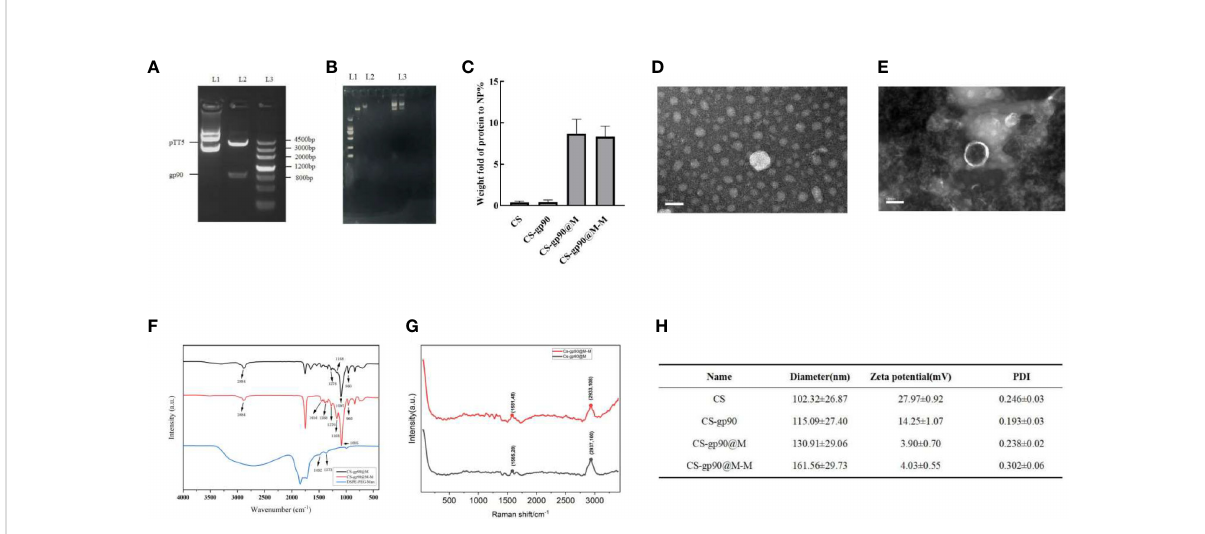
FIGURE 1 Physicochemical properties of the constructed nanoparticles. (A) gp90 gene identi fi cation L1: pTT5 plasmid DNA; L2: Digested with HindIII/ SmaI. L3: DNA marker. (B) The complexation and condensation of CS-gp90. (C) BCA assay to determine the protein content of the CS, CS- gp90, CS-gp90@M, and CS-gp90@M-M samples. (D, E) TEM image of CS-gp90 and CS-gp90@M-M nanoparticles. (F) Infrared spectra of bionic nanoparticles. (G) Raman spectra of bionic nanoparticles; (H) Hydrodynamic sizes, zeta potentials and PDI of the